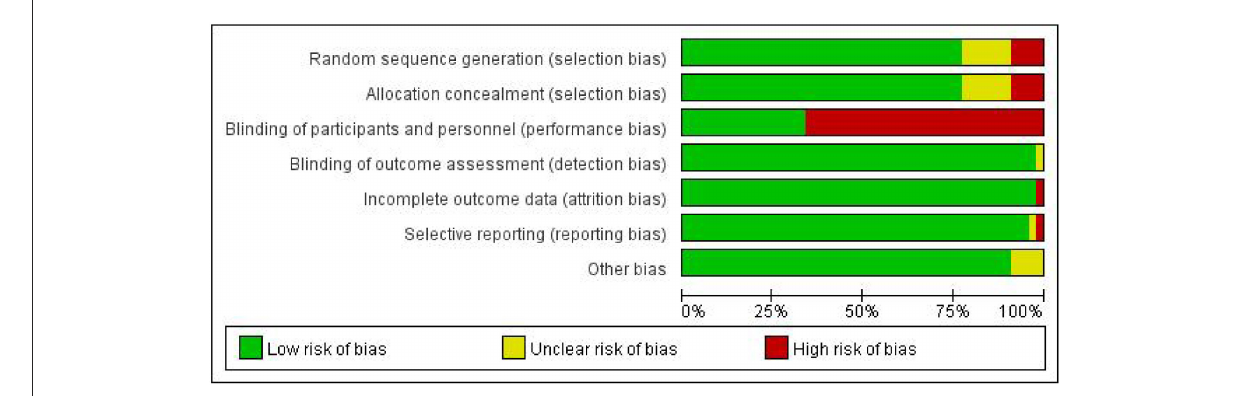
FIGURE2 Bias risk of the included studies.